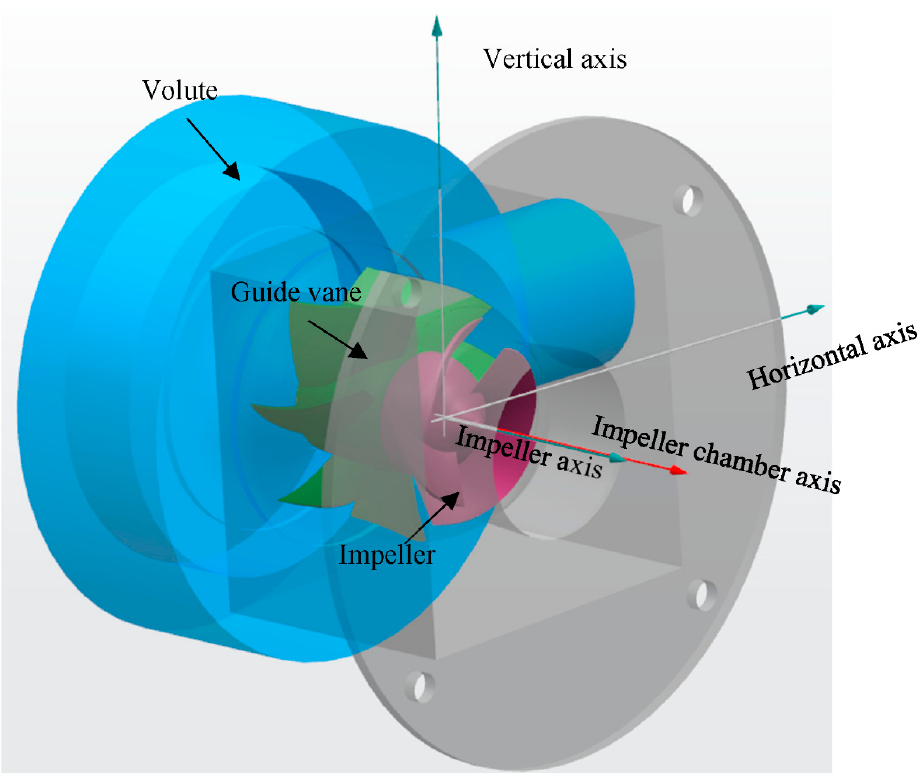
Figure 9. The installation of the impeller chamber and the schematic diagram of the chamber posi- tion.